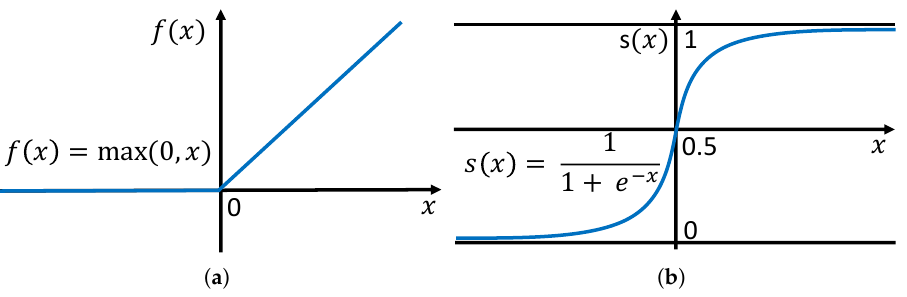
Figure 4. Activation functions. ( a ) ReLU function; ( b ) Sigmoid